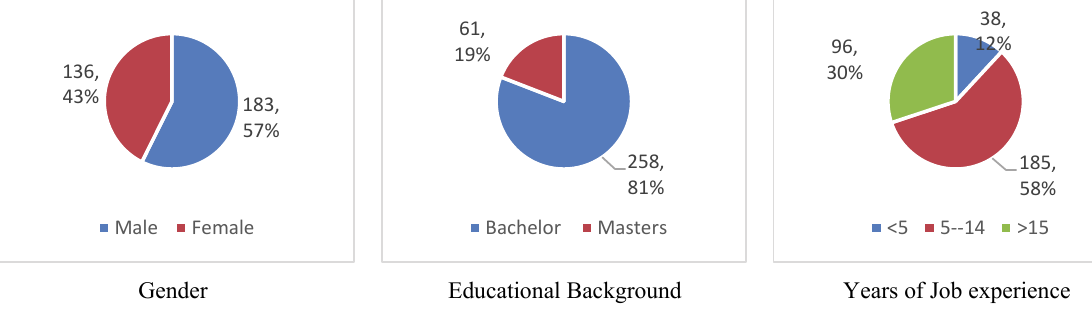
Fig. 1. Distribution of the sample members as the gender variable